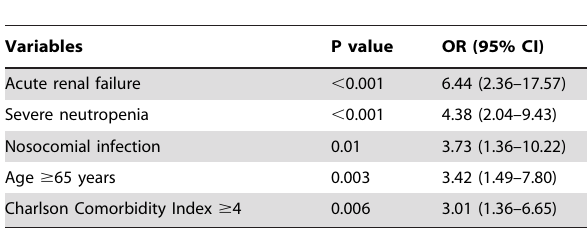
Table 2. Multivariate logistic regression analysis of risk factors for mortality in patients with bacteremia and hematological